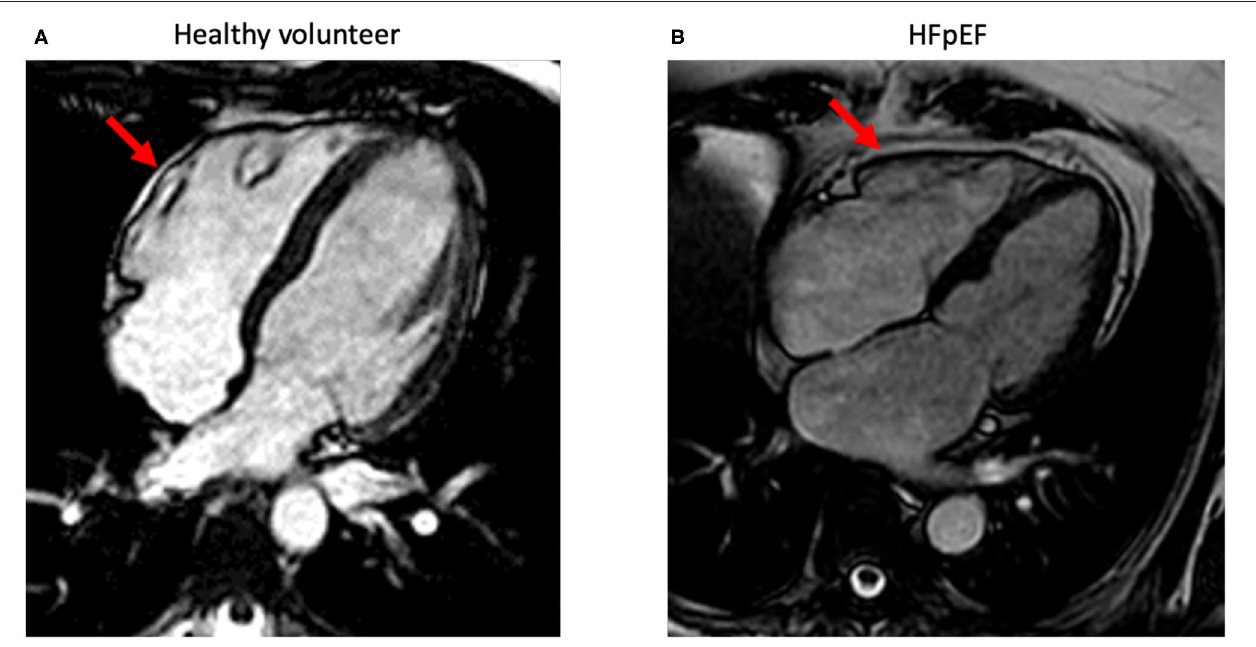
FIGURE 2 | Standard-4-chamber orientations acquired using standard steady-state free precession-cardiac magnetic imaging sequences. The images demonstrate epicardial fat (red arrow) with a minimal (normal) amount in a healthy volunteer (A) and in a patient with HFpEF (B) with increased epicardial fat surrounding the whole